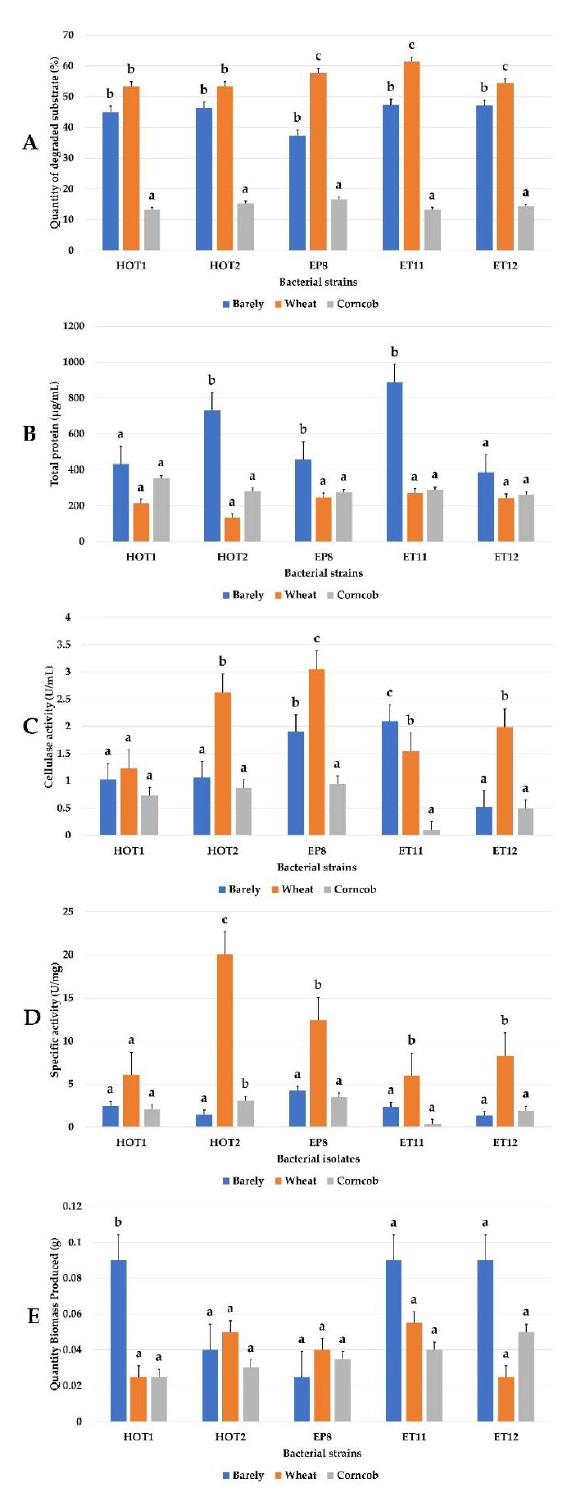
Figure 18. Effects of the cellulase producing Bacillus on: ( A ) the degradation percentage, ( B ) esti- mation of total proteins produced, ( C ) cellulase activities, ( D ) specific activities, and ( E ) quantity of biomass produced of different lignocellulosic substrates barley bran, wheat bran, and corncob. Data present mean ± standard error. Bars labelled with different letters are significantly different among the treatments at p < 0.05 using the Tukey’s HSD test. In each bar groups, bars labelled with the same letter are not significantly different from each other according to Tukey’s HSD at p <